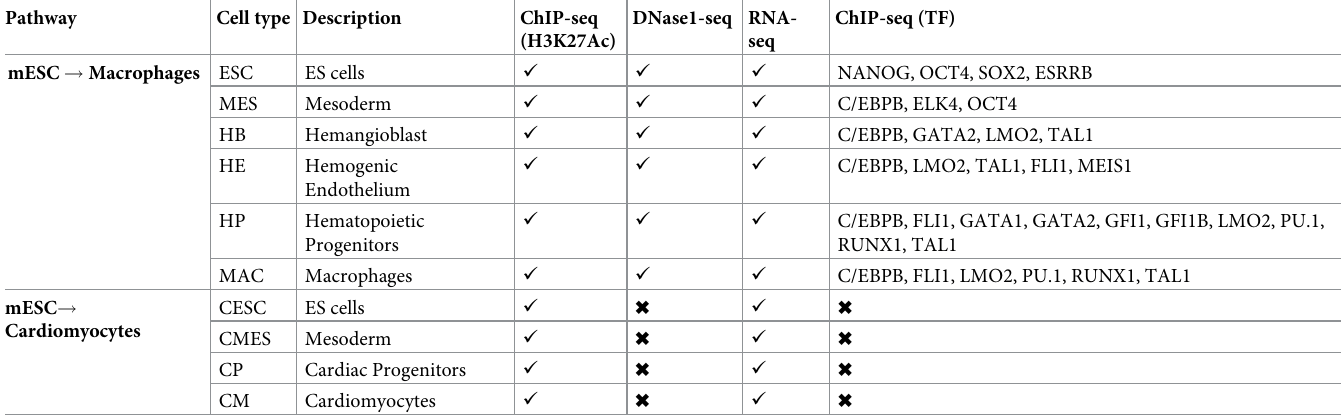
Table 1. Datasets and cell types used in this study. Pathway Cell type